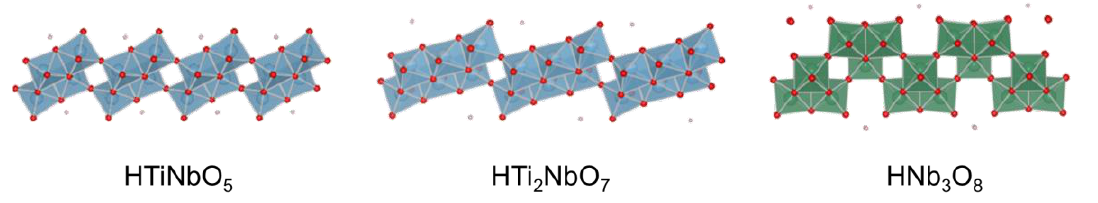
Figure 8. Schematic crystal structure of metal oxide nanosheets.